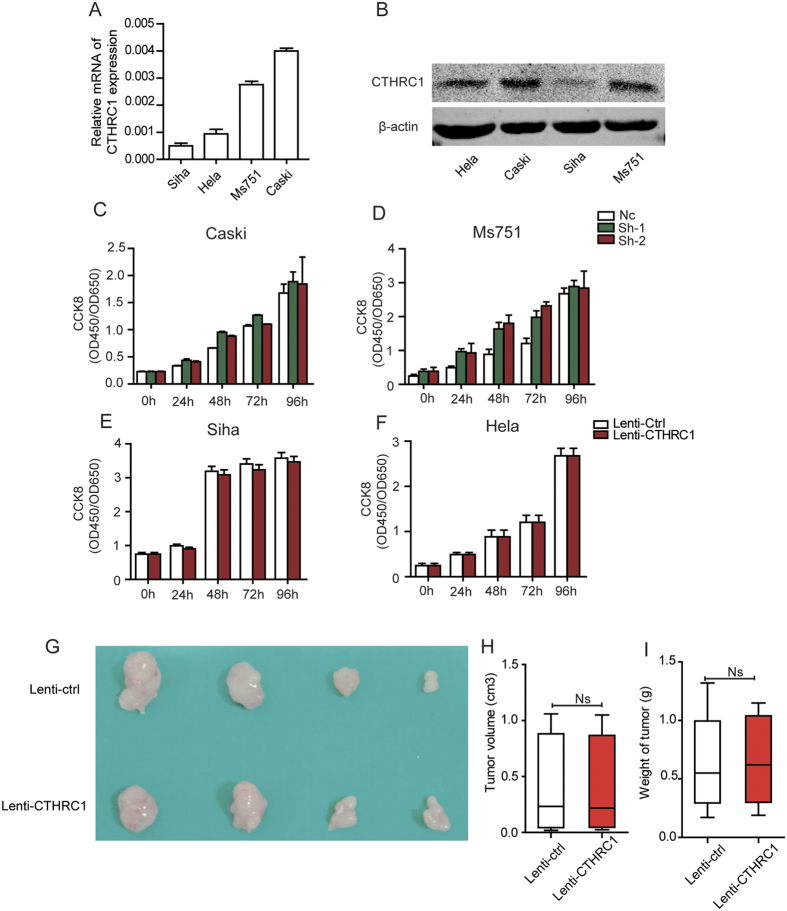
CTHRC1 have no effect on cells proliferation in vitro and tumor growth in vivo.(A and B) The expression of CTHRC1 in cell lysates from Caski, Ms751, Siha and Hela cells was detected by RT-PCR and normalized with 18S expression, western blot and normalized with β-actin expression. (C and D) The cell proliferation of Nc and sh-1, sh-2 groups in Caski (C) and Ms751 (D) cells were determined by CCK8 assay at 0, 24, 48, 72, 96 h, respectively. Values are means ± SD, n = 5. (E and F) The cell proliferation of control and Lenti-CTHRC1 in Siha and Hela cells was determined by CCK8 assay at 0, 24, 48, 72, 96 h, respectively. Values are means ± SD, n = 5. (G) Morphologic characteristics of tumors from mice inoculated with Siha/Control and Siha/Lenti-CTHRC1 cells. (H and I) Tumor volumes and tumor weights of Nc and Lenti-CTHRC1 groups from G. n = 6.